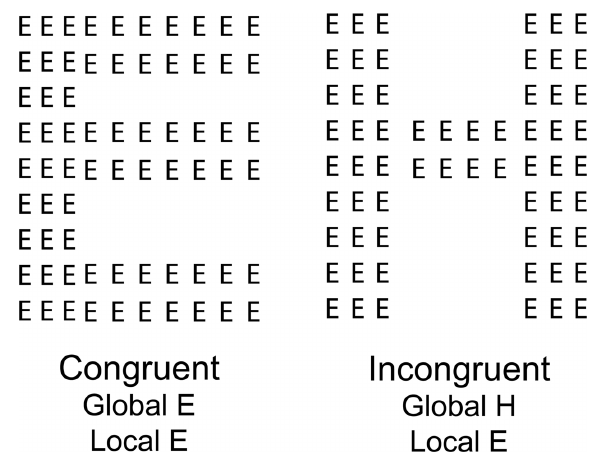
FIGURE 1 | An example of a Navon task stimulus (Navon, 1977). The participant is asked to identify a target letter that can be present at both the local and global level (congruent stimulus) or may be present at either the local or global level (incongruent